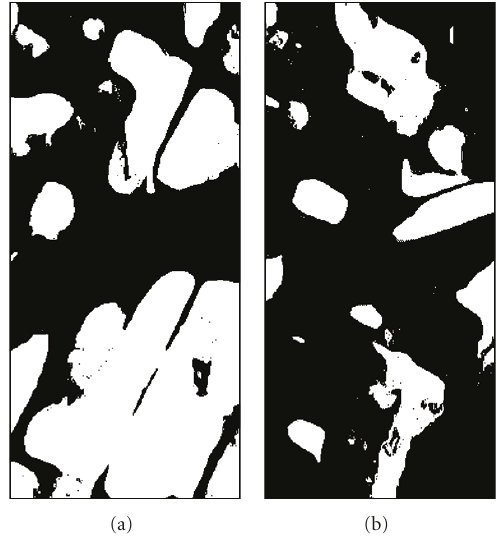
Figure 10: Segmentation results on a single channel of the PiSAR image by the method in [14]. (a) hh channel after 1380 iterations, and (b) hv channel after 2100